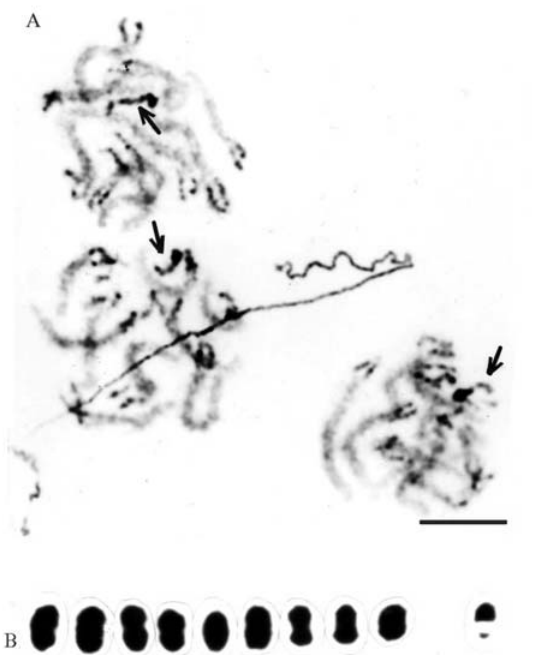
Figure 1 - Meiosis of a Cycloneda sanguinea male. A) Pachytene show - ing the X and y chromosomes aligned end-to-end until the formation of a pseudo-ring. B) Metaphase I karyotype. Bar = 5 µ